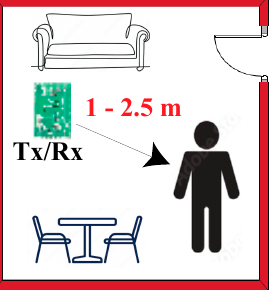
Figure 4. Indoor experimentation setting for human pose acquisition.